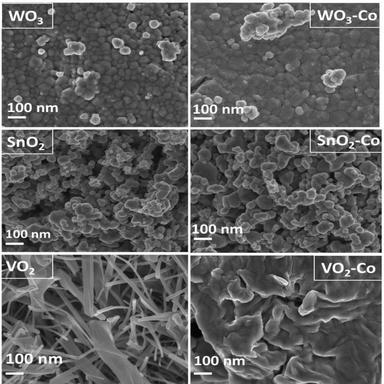
SEM images of WO3, WO3-Co, SnO2, SnO2-Co, VO2, and VO2-Co. (For interpretation of the references to colour in this figure legend, the reader is referred to the web version of this article.)